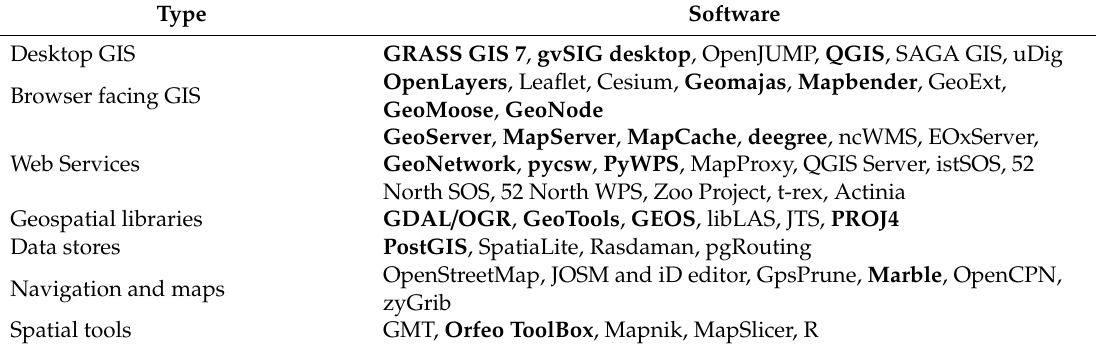
Table 4. OSGeo Live software packages grouped according to the OSGeo Live 13.0 release [41]. OSGeo projects that passed incubation are in bold.